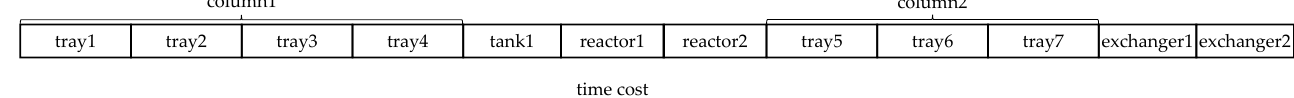
Figure 6. Calculation time with a single core.